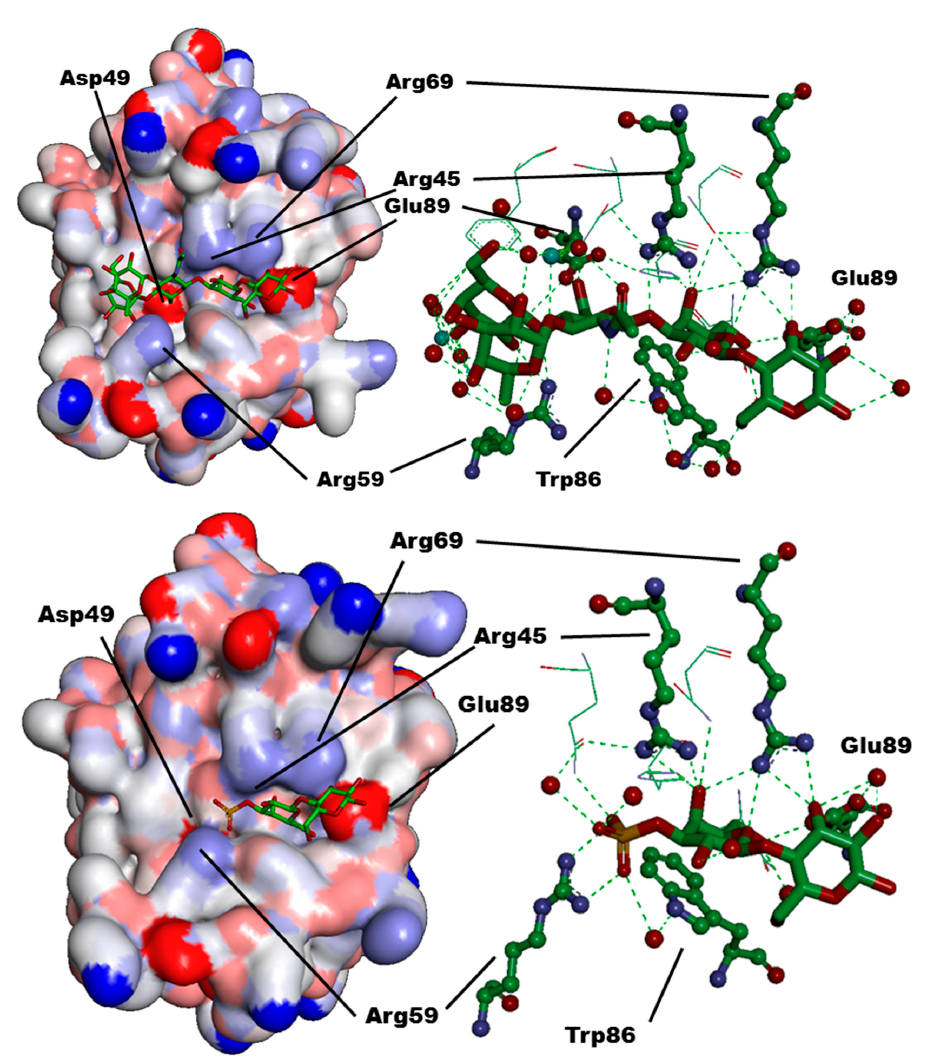
Figure 8. Human galectin-8N (Connolly surfaces and binding sites) loaded with lacto- N -fucopentaose-III ( top ) and 3 ′ -sulfated lactose ( bottom ) (PDB 3AP9).